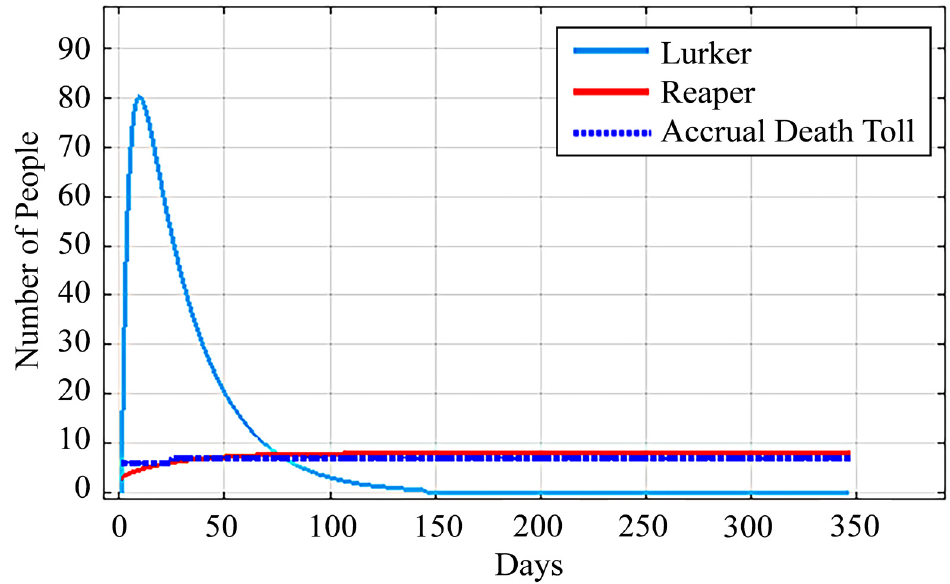
Figure 15. Epidemic trend based on SEIARN that trend chart for infected and cured patients.